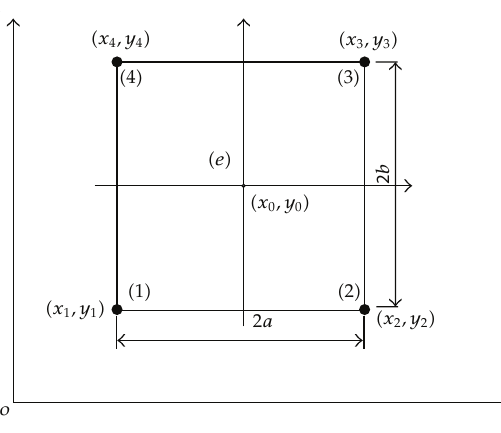
Figure 1: 4-node rectangular manifold